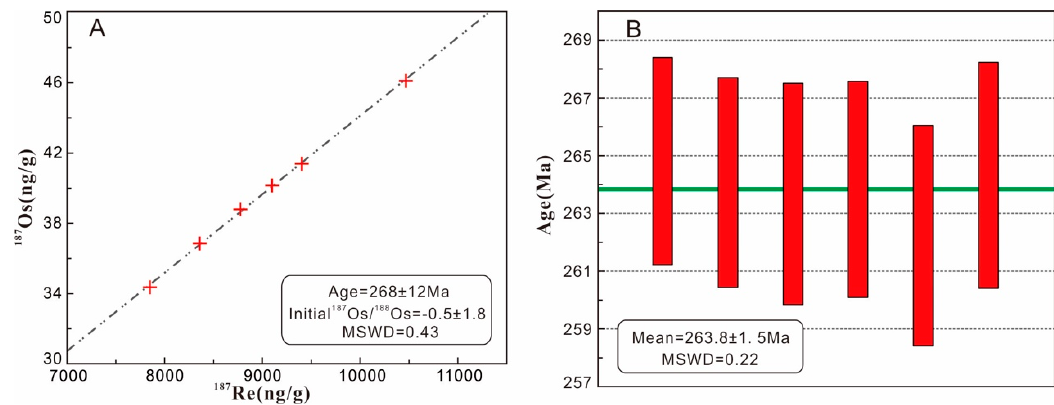
Figure 4. Isochron ( A ) and weighted mean ages ( B ) of molybdenite from the Lyangar W-Mo deposit.